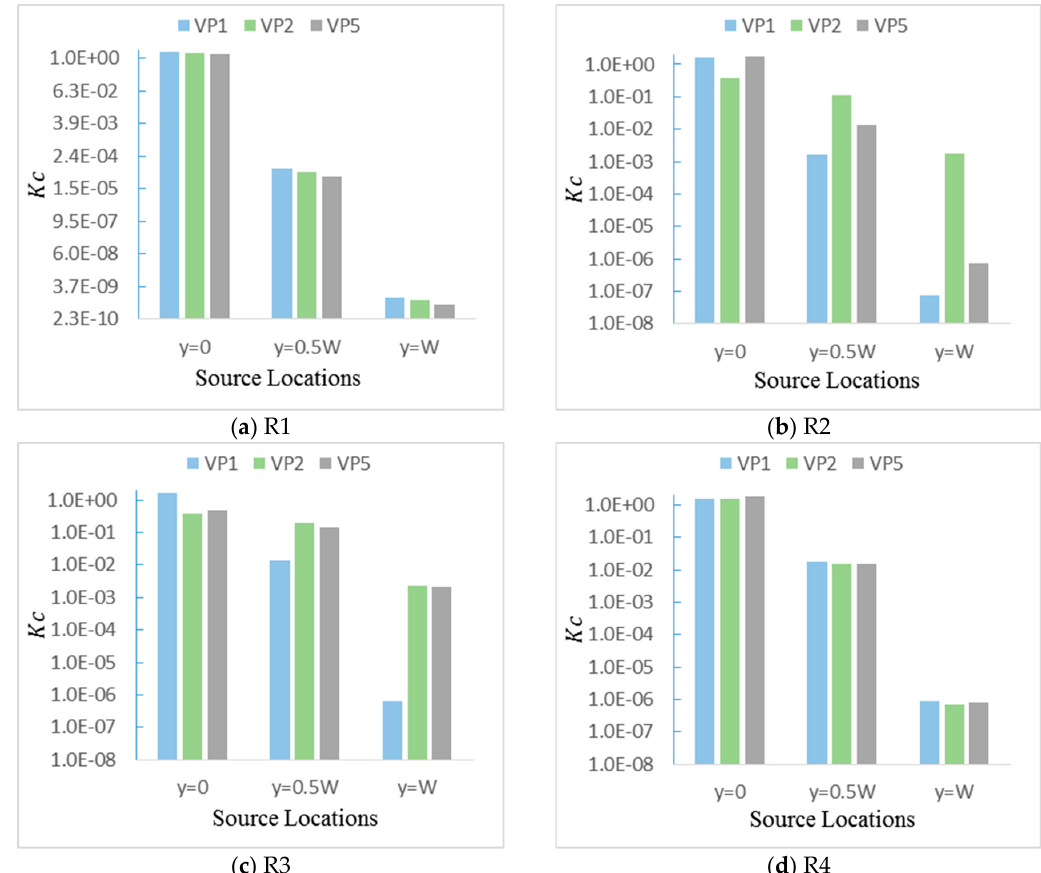
Figure 10. Nondimensional concentration (K c ) at the z = 1.2 m cross-section in each room for di ff erent source locations (y = 0 W, 0.5 W, 1 W). ( a ) R1; ( b ) R2; ( c ) R3; ( d ) R4.